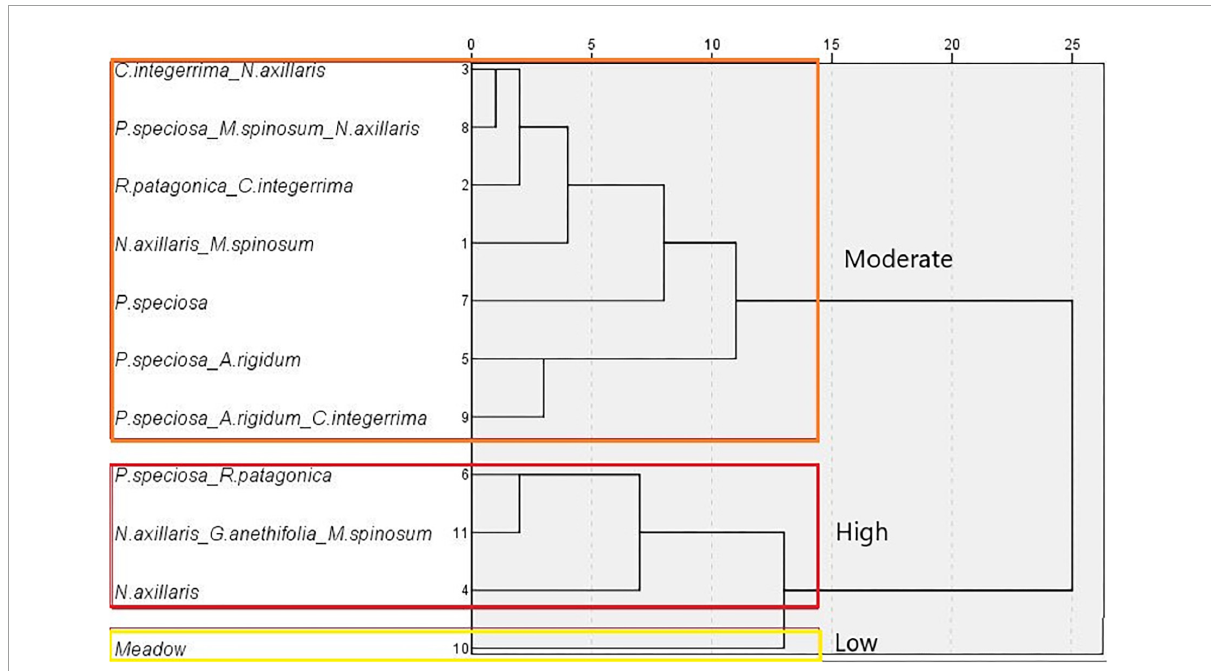
FIGURE7 Dendrogram from the ascendant hierarchical classification analysis. The fire hazard category (low, moderate, and high) for each vegetation unit is showed.